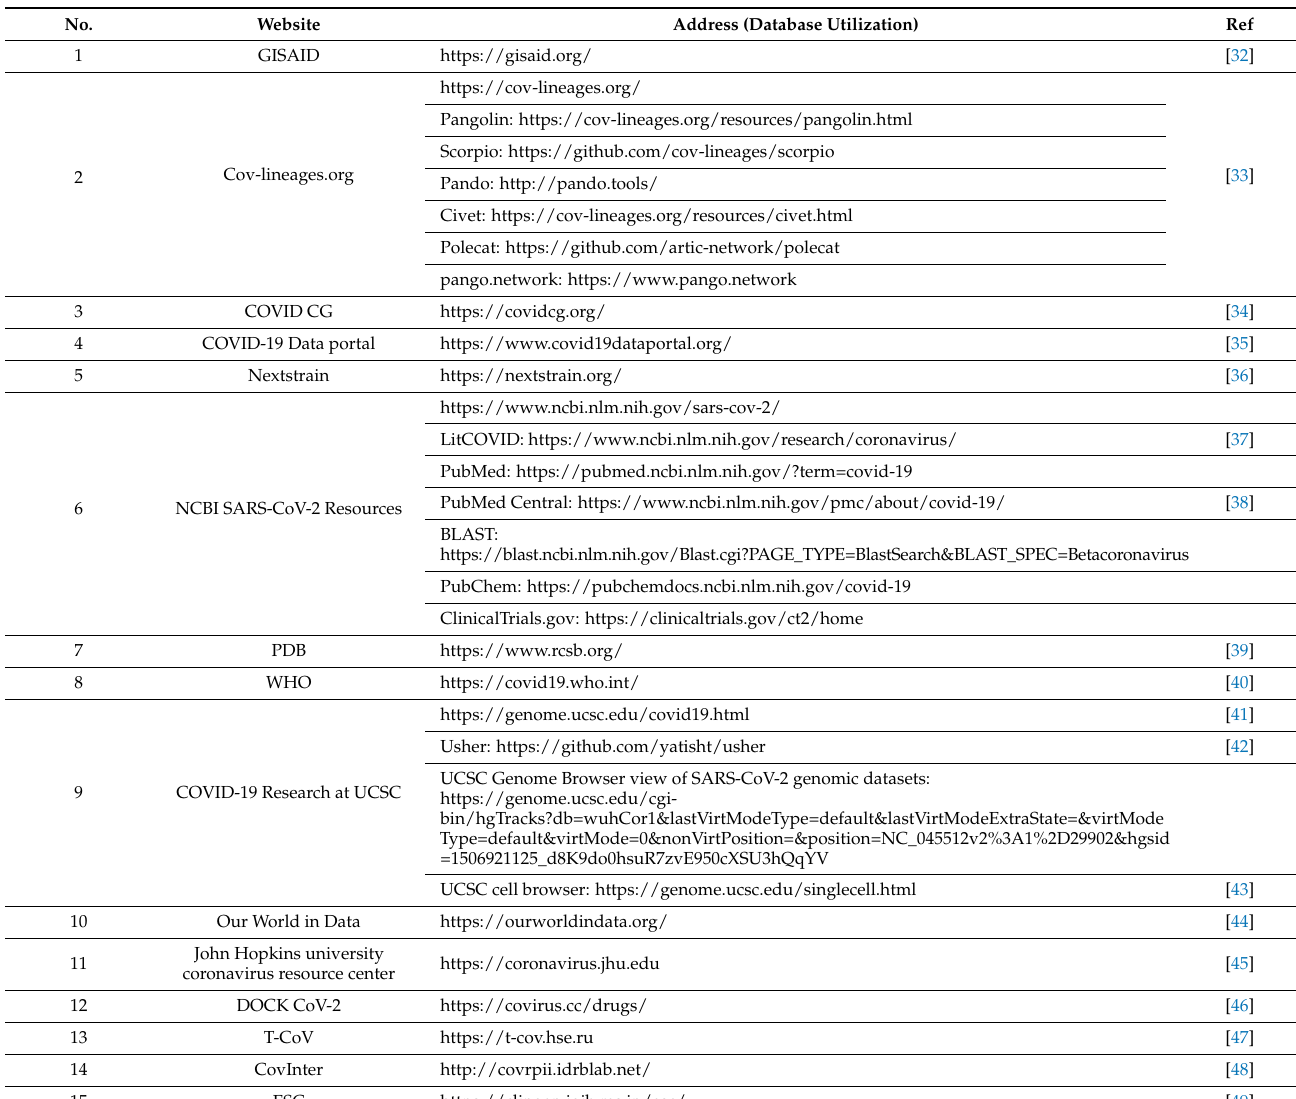
Table 2. COVID-19 database addresses and associated